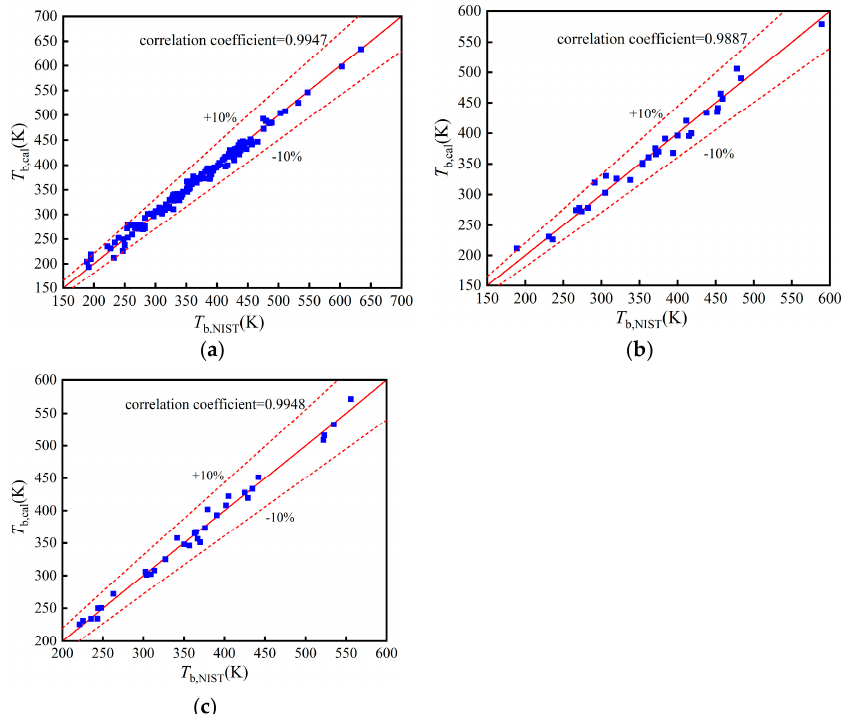
Figure A1. Comparison of T b : ( a ) Training set; ( b ) Validation set; ( c ) Test set.